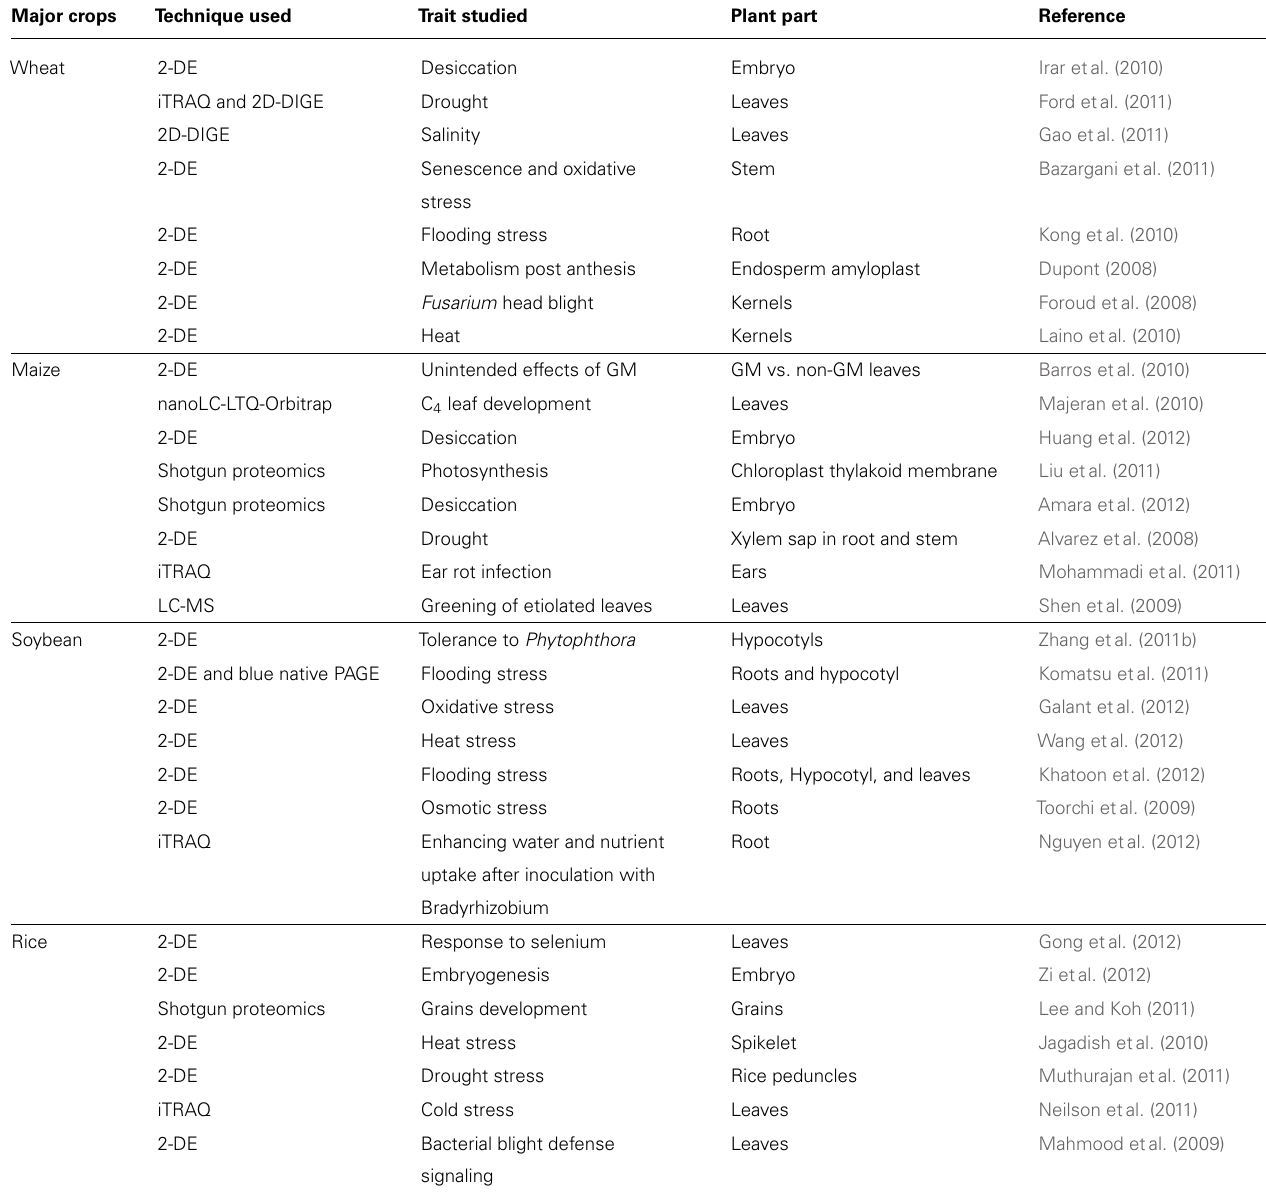
Table 1 |A short overview of recent gel-based and gel-free proteomics methods as biotechnological tools that could provide knowledge for crop improvement programs. Major crops